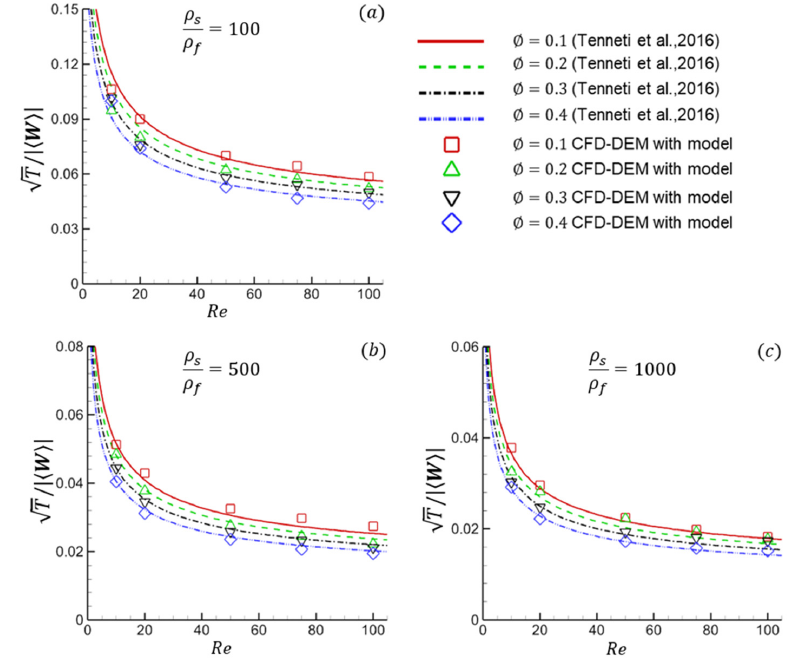
Figure 2. Comparisons of the steady-state granular temperatures calculated by computational fluid dynamic-discrete element method (CFD-DEM) simulations with the proposed model and those by the formula from Tenneti et al. [20]. The granular temperature is scaled by the mean fluid-particle slip velocity (cid:104) W (cid:105) = , where the angular brackets denote the average over the system. The solid–fluid density ratio for ( a ), ( b ), and ( c ) are 100, 500, and 1000, respectively. As the agreements between scatters and lines were similar for the density ratios 2000 and 1000, the comparisons are only shown for density ratio at 1000.